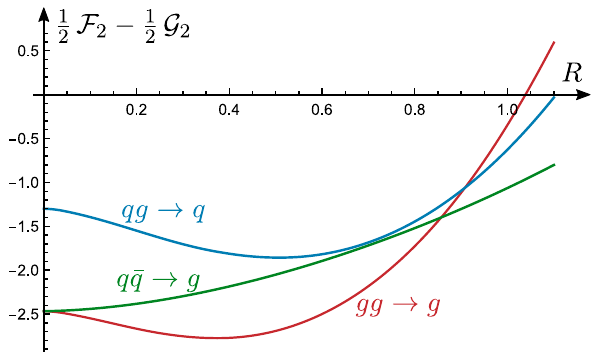
Fig. 5 The coefficient of the single logarithm ¯ α 2 s L 2 resulting from both CLs and NGLs with C–A and k t clustering